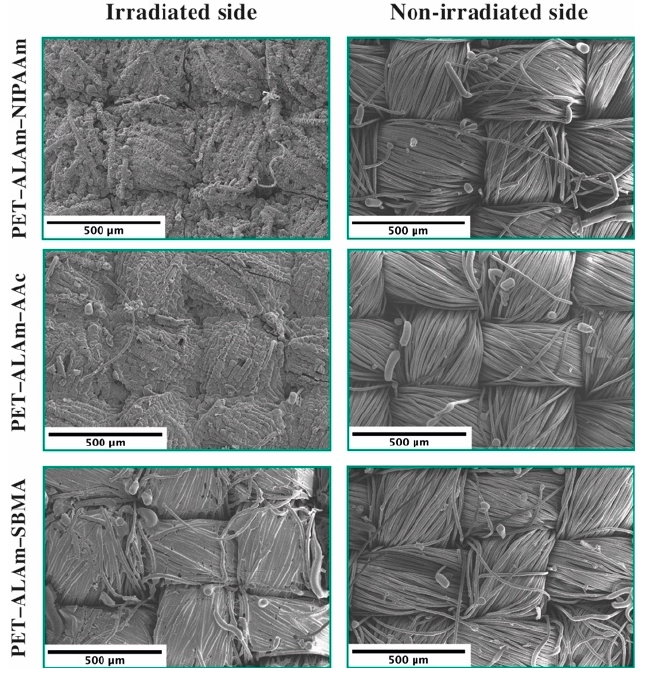
Figure 3. SEM morphologies of irradiated side and non-irradiated side of hydrogel modified PET fabrics.